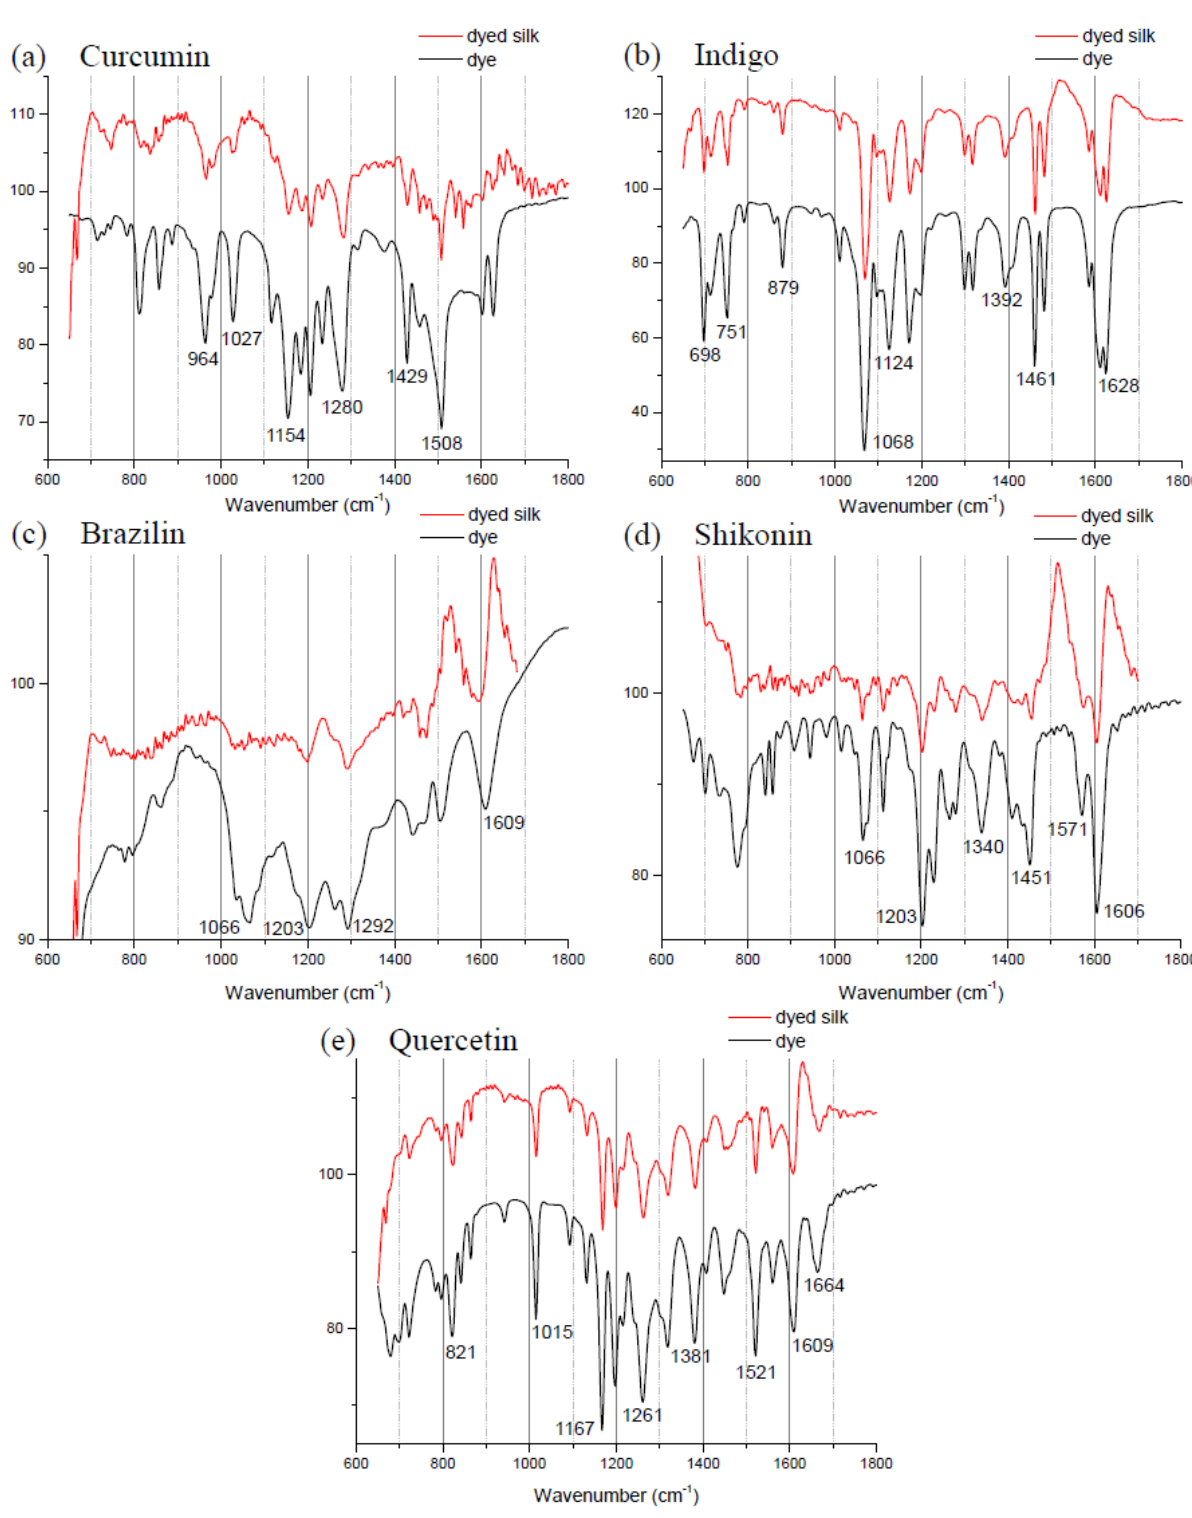
Figure 1. Fourier transform infrared spectra of five commercial dyes and the dyed silk fabric between 600 and 1800 cm − 1 : ( a ) curcumin; ( b ) indigo; ( c ) brazilin; ( d ) shikonin; and ( e )